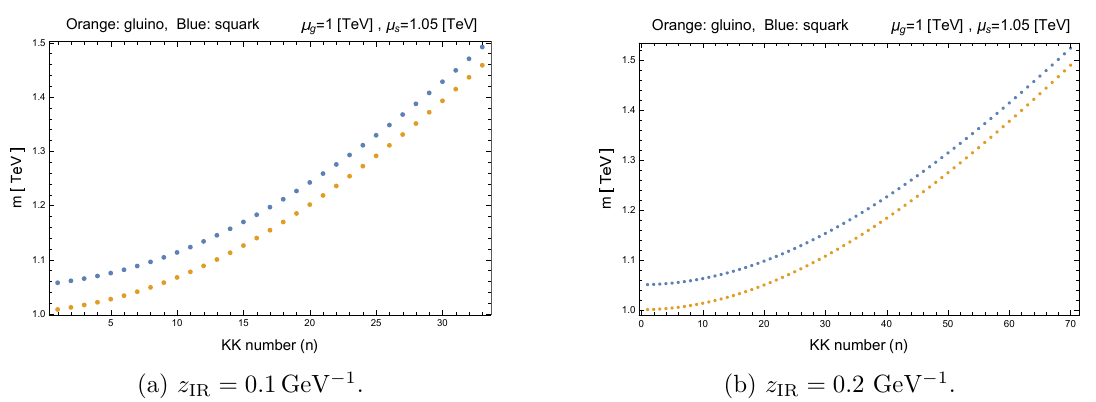
Figure 6. Gluino and squark KK